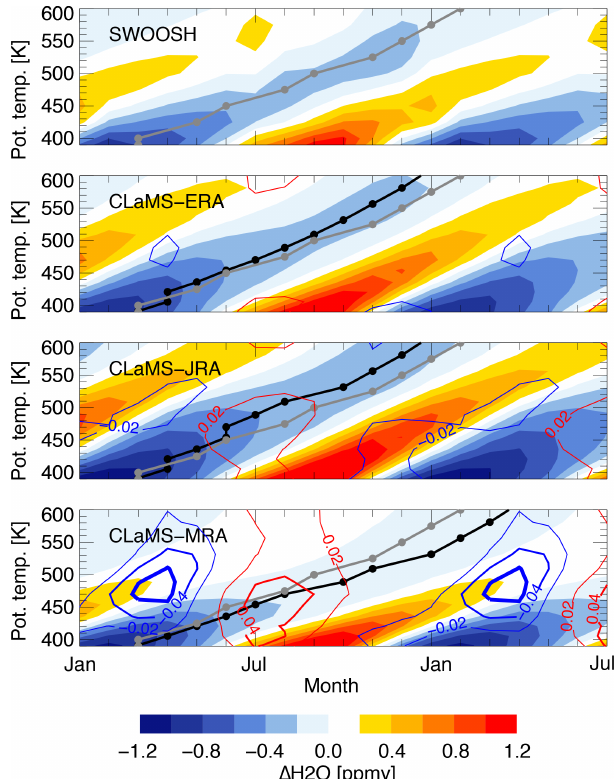
Figure 6. Climatological structure of the stratospheric tape-recorder signal based on SWOOSH and the three CLaMS runs. The tape recorder is defined as anomalies in tropical (20 ◦ S–20 ◦ N) mean H 2 O relative to the climatological mean at each level (color shad- ing). The phase of upward propagation (solid circles connected by a line) is defined by the largest correlation with the layer below. For ease of comparison, propagation based on SWOOSH is marked in each panel using gray circles connected by a gray line. Red and blue contours indicate positive and negative contributions of CH 4 to H 2 O anomalies (in units of ppmv, at intervals of